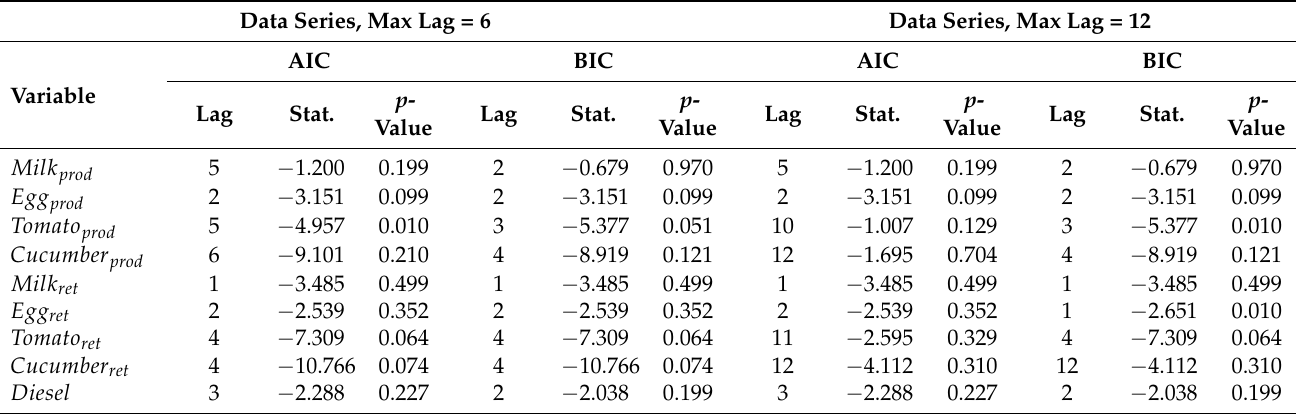
Table 3. Augmented Dickey–Fuller tests.